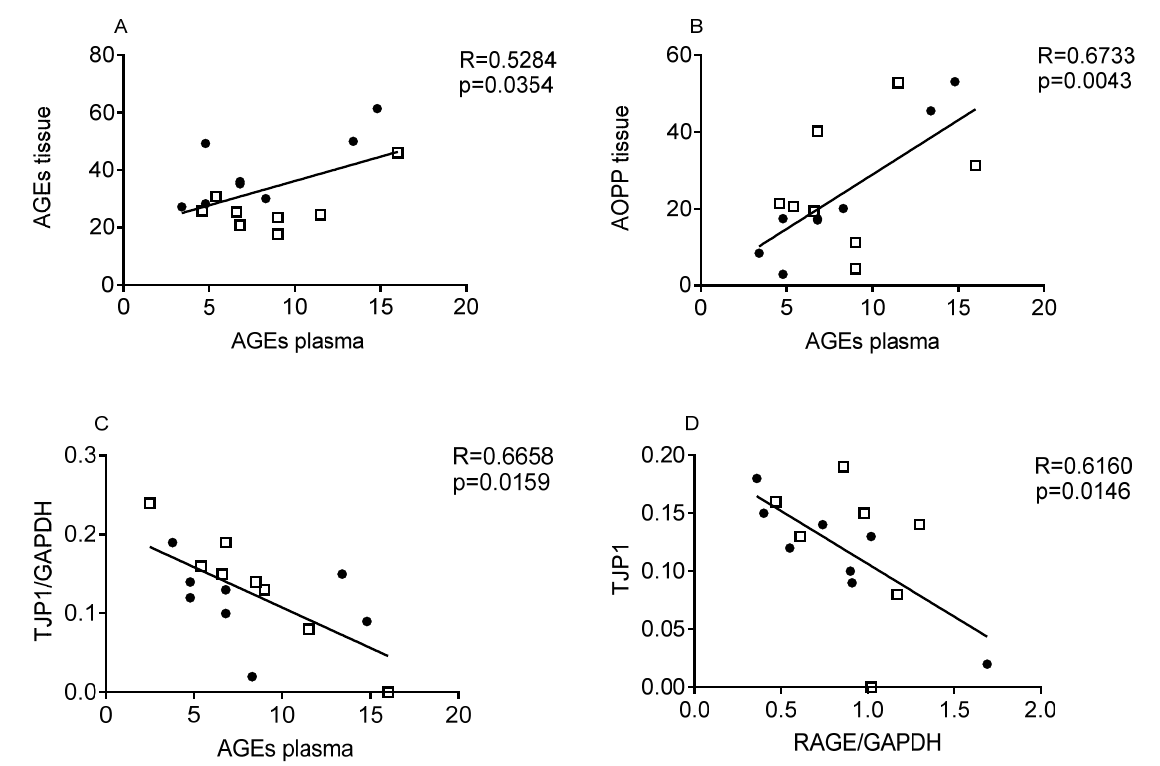
Nutrients 2023 , 15 , x FOR PEER REVIEW 8 of 12 Figure 3. Correlation between Advanced Glycated End-products (AGEs) levels in the plasma of CD patients and in mucosal samples ( A ); correlation between AGEs levels in the plasma and Advanced Oxidation Protein Products (AOPPs) in mucosal samples ( B ); correlation between AGEs levels in the plasma and Tight junction protein-1 (TJP1) gene expression ( C ) in mucosal samples; correlation between TJP1 and Receptor for Advanced Glycation End products (RAGE) gene expression ( D ) in mucosal samples. Dotted symbols ( • ) represent controls; square symbols ( ) represent IN